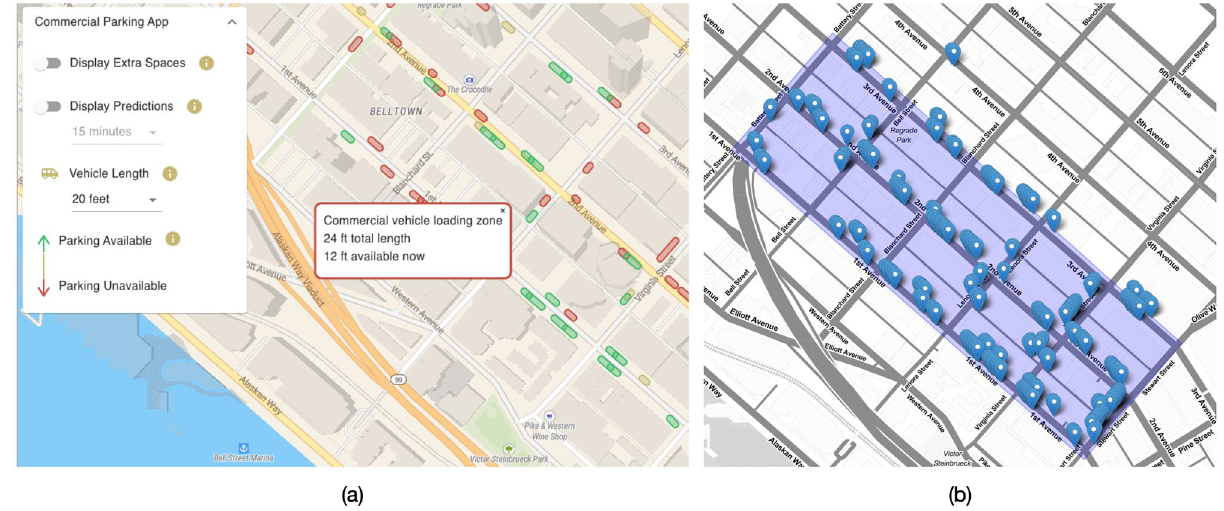
Figure 2. ( a ) OpenPark, a real-time curb availability information application. ( b ) Study area with curb sensor locations. The maps were created using Leaflet library 31 .